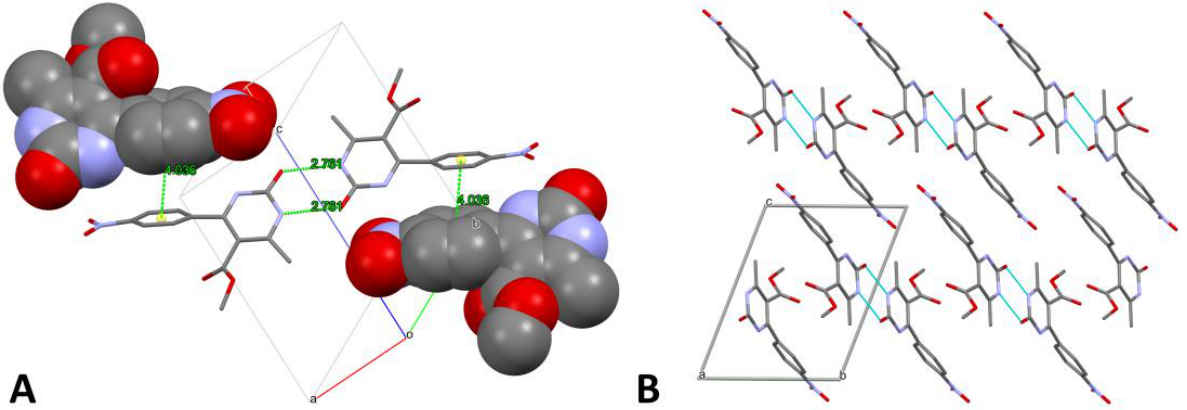
Figure 4. ( A ) Spacefill-stick model of 2 in an arbitrary orientation, evidencing the main H-bonds and the π-π stacking interactions. ( B ) Stick model showing the crystal packing along the a axis. Hydrogen atoms are omitted for the sake of clarity.